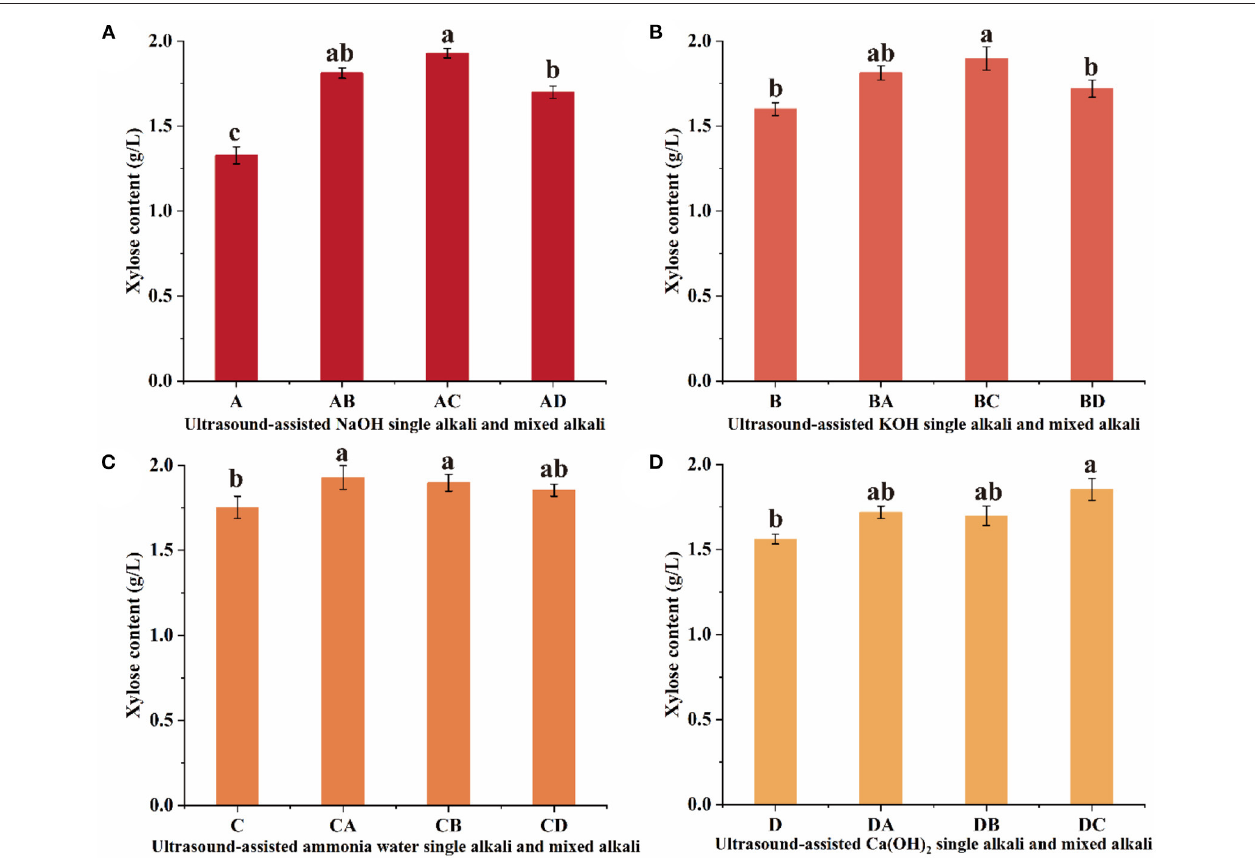
FIGURE 1 | Effects of ultrasonic-assisted (A) NaOH, (B) KOH, (C) ammonia water, and (D) Ca(OH) 2 and its mixed alkaline solution on xylose content from sugarcane bagasse enzymatic hydrolysate. Error bars are the standard deviation of three replications and different lowercase letters (a–c) on top of the bars indicate a significant difference ( P < 0.05). Different letters are significantly different ( P <